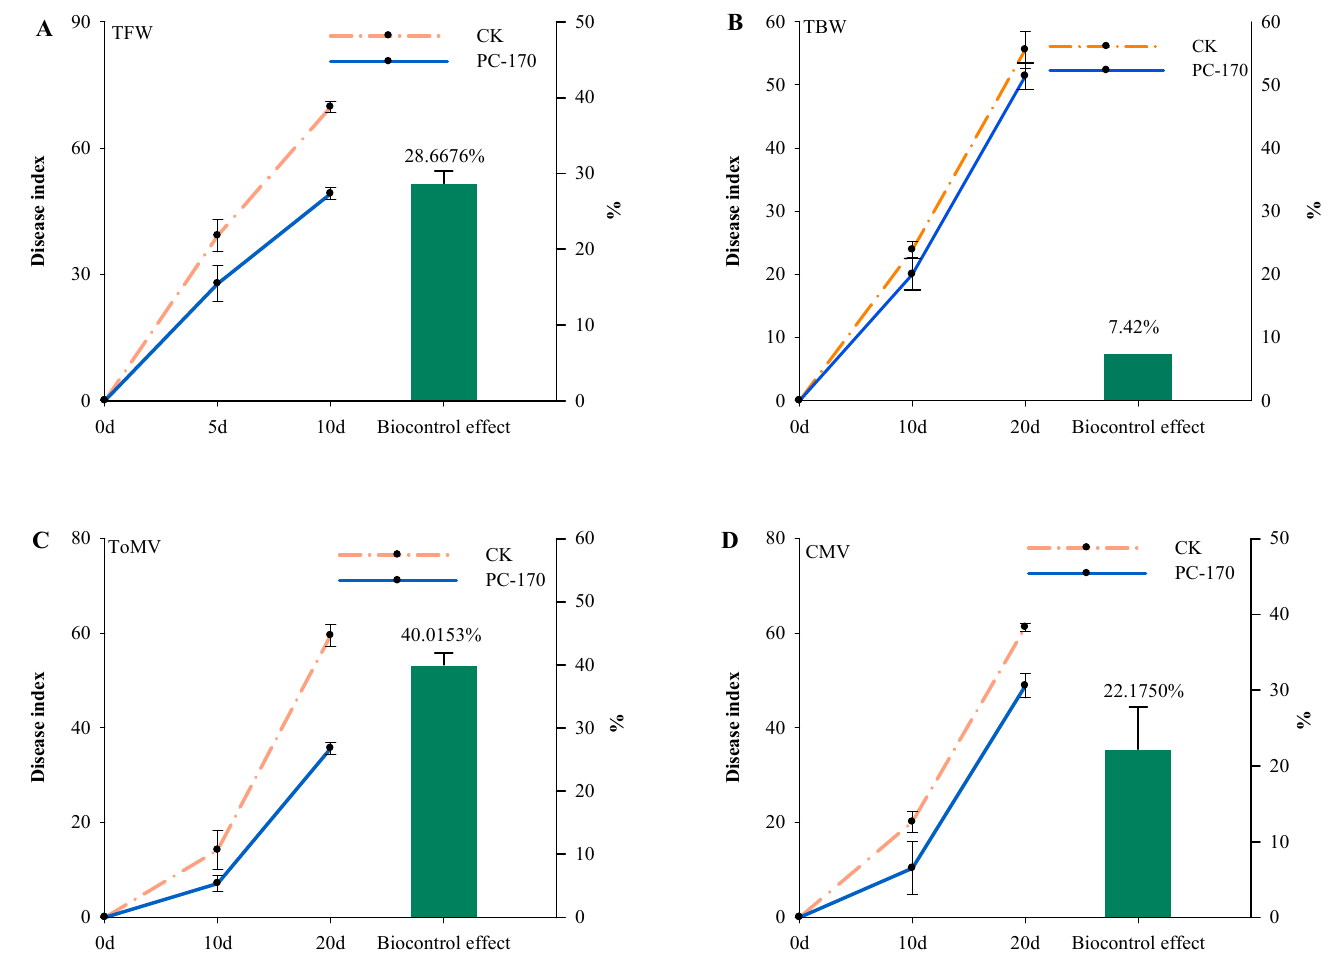
Figure 3. Pochonia chlamydosporia increases tomatoes’ resistance to different plant pathogens. ( A ) Percentage disease level at 5 d and 10 d, and biocontrol effect, after tomato fusarium wilt ( Fusarium oxysporum f. sp. Lycopersici (Sacc.) Snyder and Hansen; TFW) inoculation. ( B ) Percentage disease level at 10 d and 20 d, and biocontrol effect, after tomato bacterial wilt ( Ralstonia solanacearum (Smith) Yabuuchi et al.; TBW) inoculation. ( C ) Percentage disease level at 10 d and 20 d, and biocontrol effect, after tomato mosaic virus (ToMV) inoculation. ( D ) Percentage disease level at 10 d and 20 d, and biocontrol effect, after cucumber mosaic virus (CMV) inoculation. Three replications were maintained for each treatment for disease incidence study.